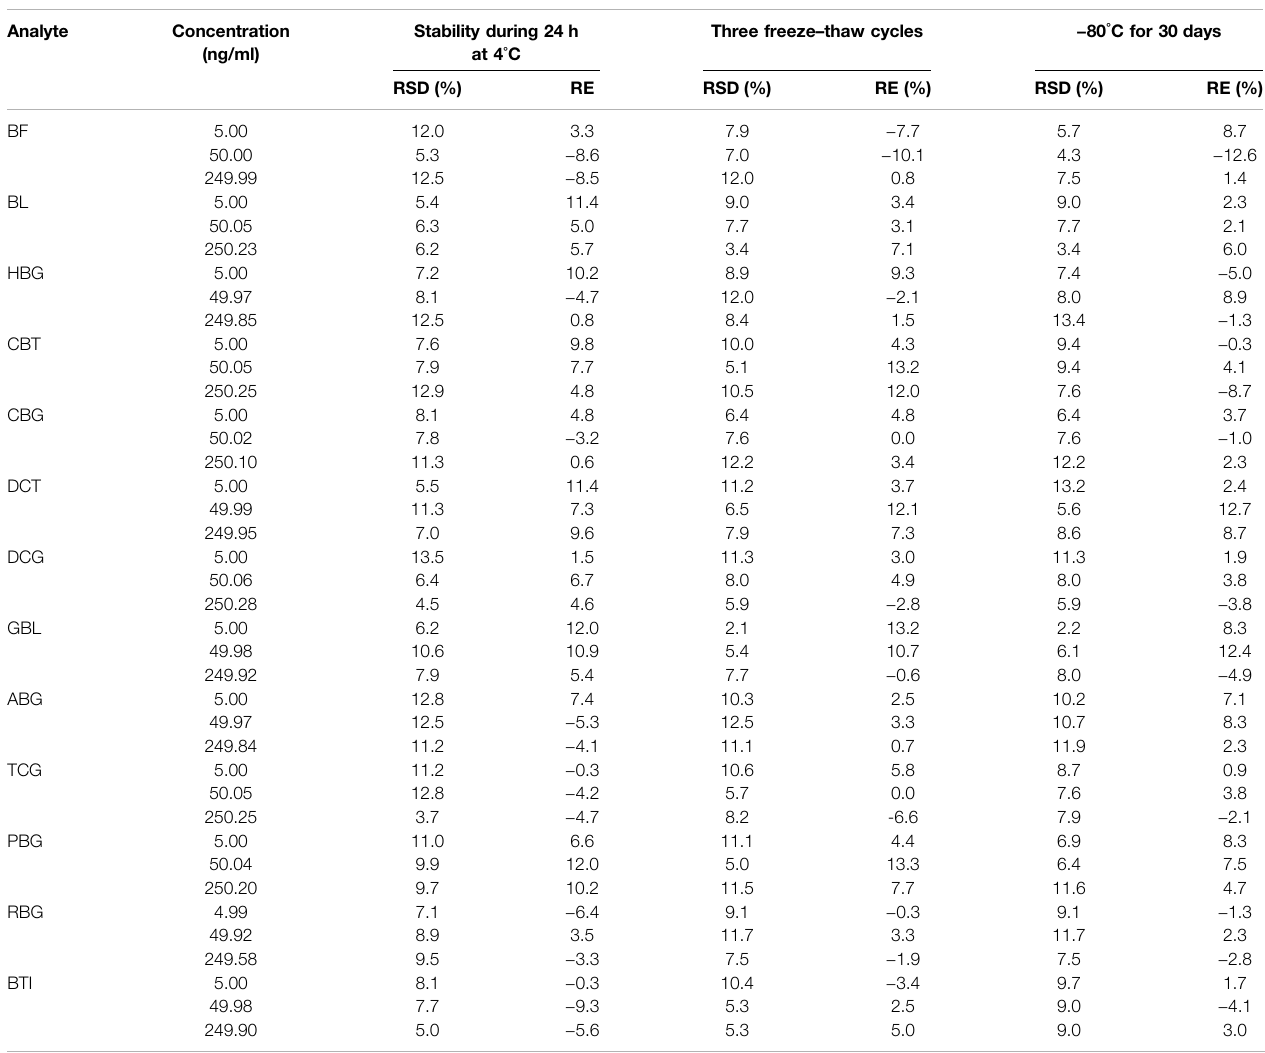
TABLE 4 | Stability of 13 analytes in the rat plasma at three QC levels ( n = 6). Analyte Concentration Stability during 24 h (ng/ml) at 4 °